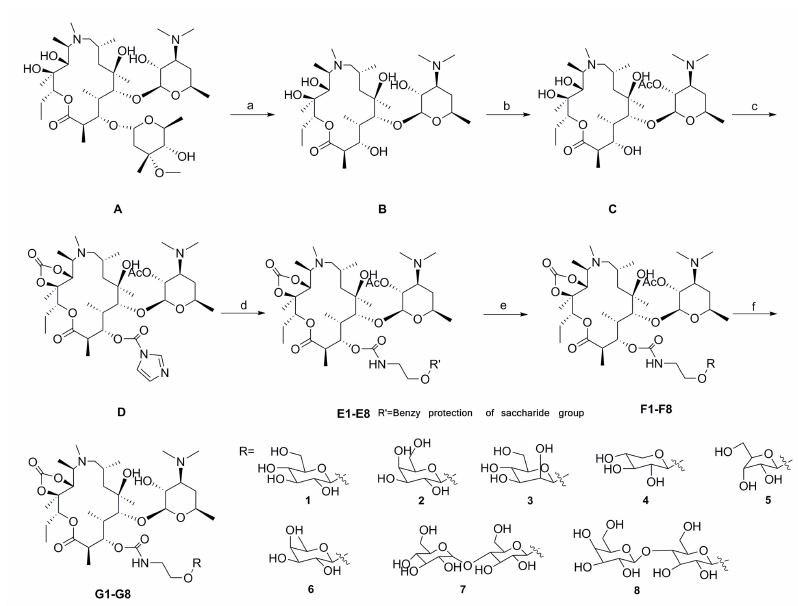
Figure 3. Structure of the intermediates 1f – 8f